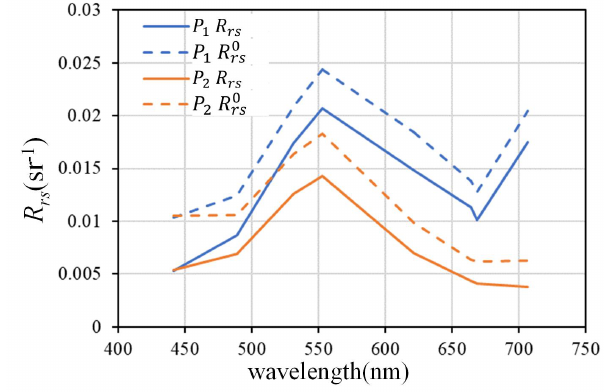
Figure 6. In situ measured R rs and image R 0 rs in the bands utilized in QAA V 5 and QAA M 14 (443 nm, 490 nm, 532 nm, 555 nm, 620 nm, 665 nm, 667 nm, 708 nm) of typical samples P 1 and P 2 in the study